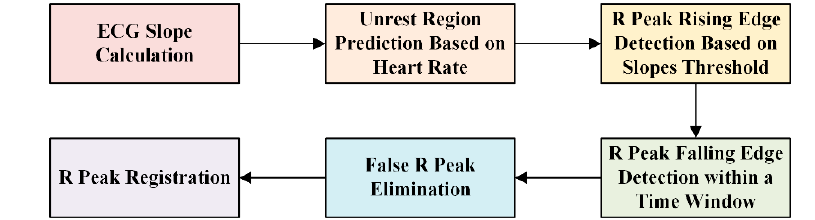
Figure 10. Block diagram of R peak detection.